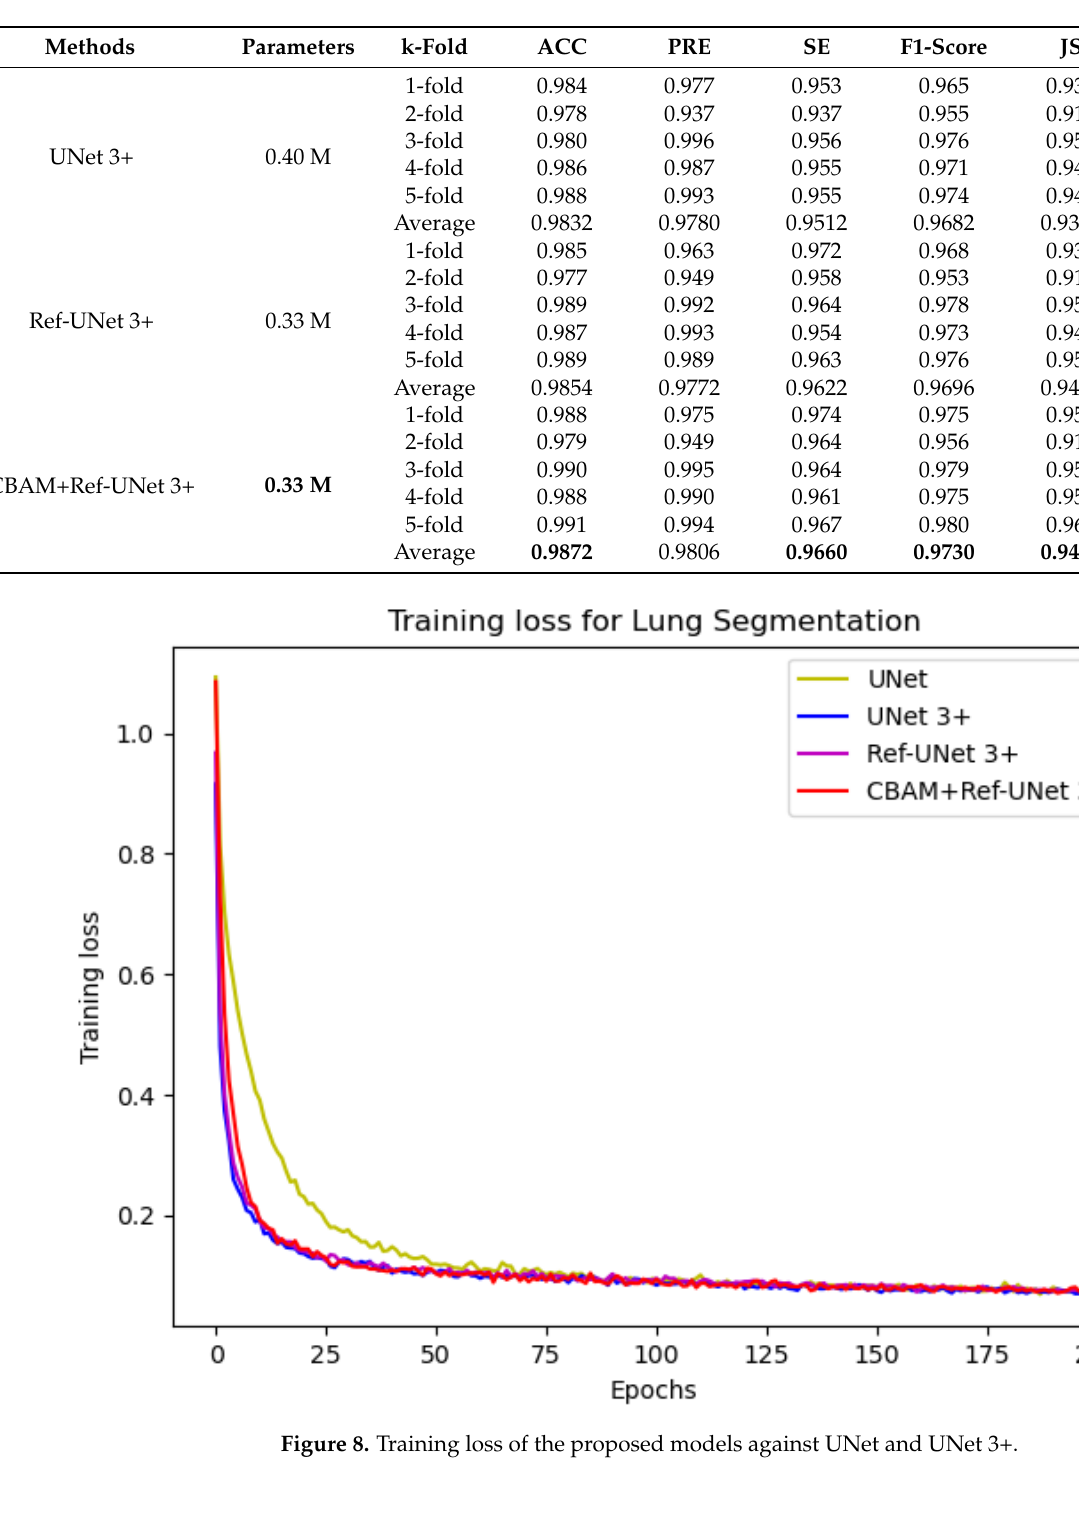
Figure 9. Mean IoU of the proposed models against UNet and UNet 3+. The comparison results are given in Table 3. It can be seen that CBAM+Ref-UNet 3+ achieves the highest average scores on multiple metrics. Moreover, CBAM+Ref-UNet 3+ can accomplish the best segmentation performance with fewer parameters.